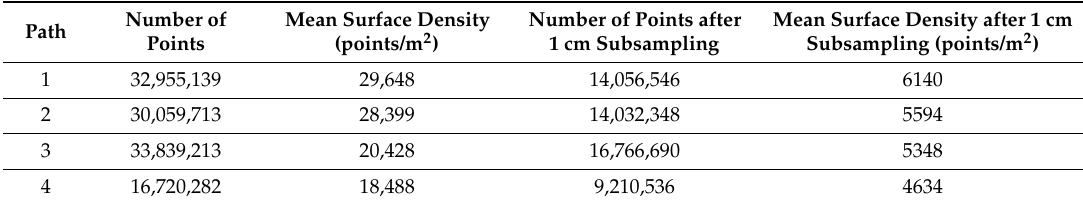
Table 5. Point cloud features; the surface density is estimated by counting for each point the number of neighbors inside a sphere of three centimeters radius ( R ) and dividing this value by the sphere max section ( π R 2